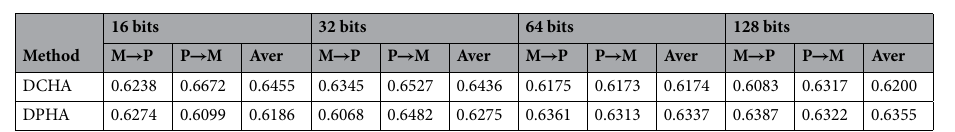
Table 4. The mAP of ablation experiments on ADNI2 with different lengths of hash